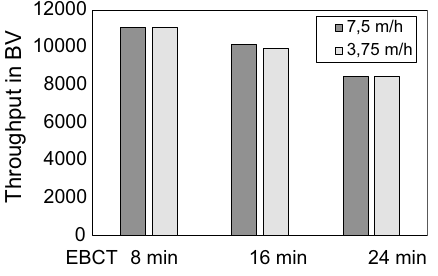
Fig. 6 Throughput achieved at a 100% breakthrough for PFBA (matrix: PFAS‑polluted groundwater,